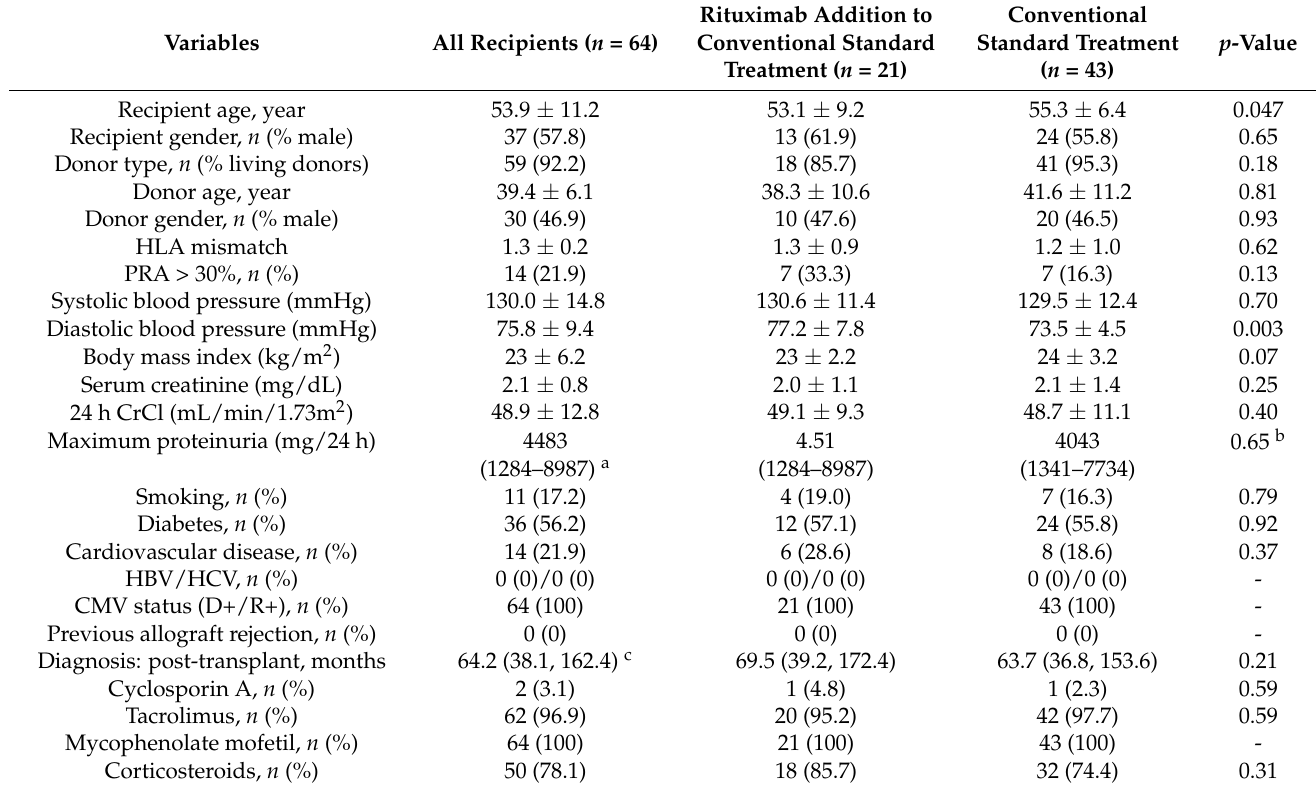
Figure 1. Flowchart of participants included in the study. FSGS: focal segmental glomerulosclerosis; Table 1. Participants’ baseline characteristics.